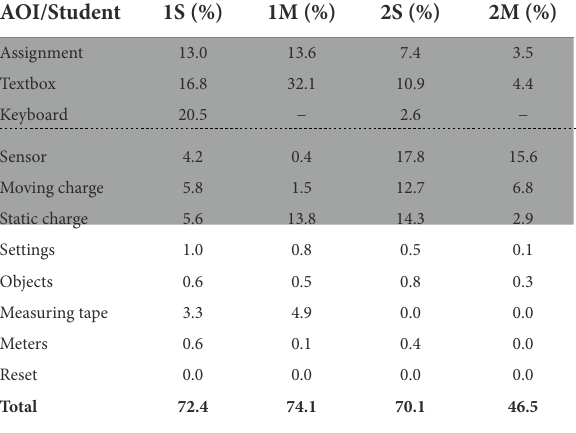
S and M refer to the sharing student and monitoring student, respectively. The shaded AOIs are used in further analyses, and the dashed line separates the AOIs referring to the problem and simulation view.